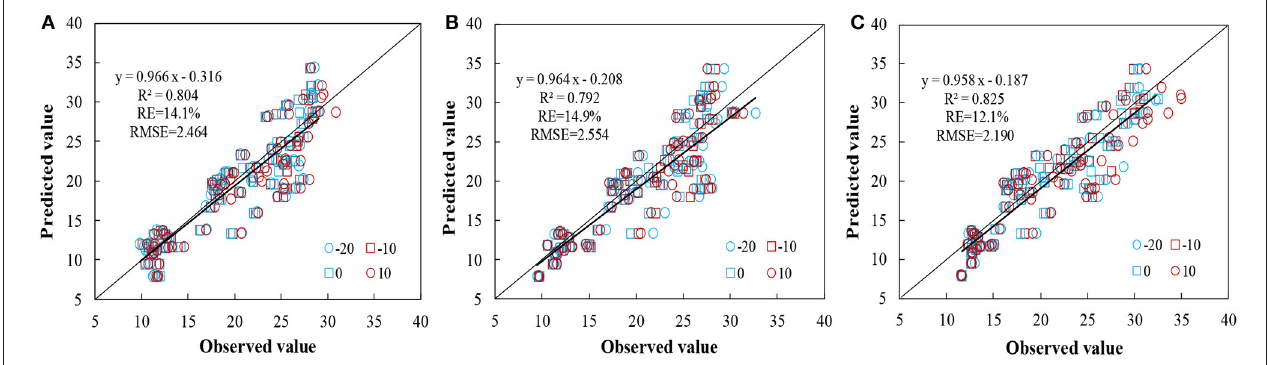
FIGURE 13 | Comparison between estimated and measured aerial N uptake based on DIDA (A) , DDn (B) , and mRPA (C) for − 20 ◦ to + 10 ◦ combinations ( n = 252, p <